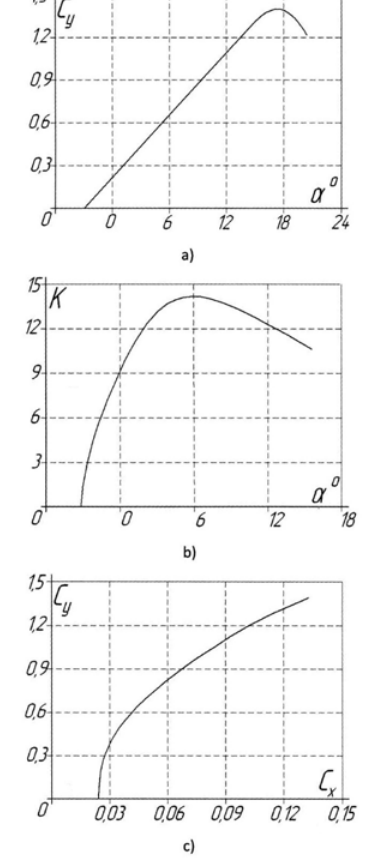
Fig. 4. Ratio of C